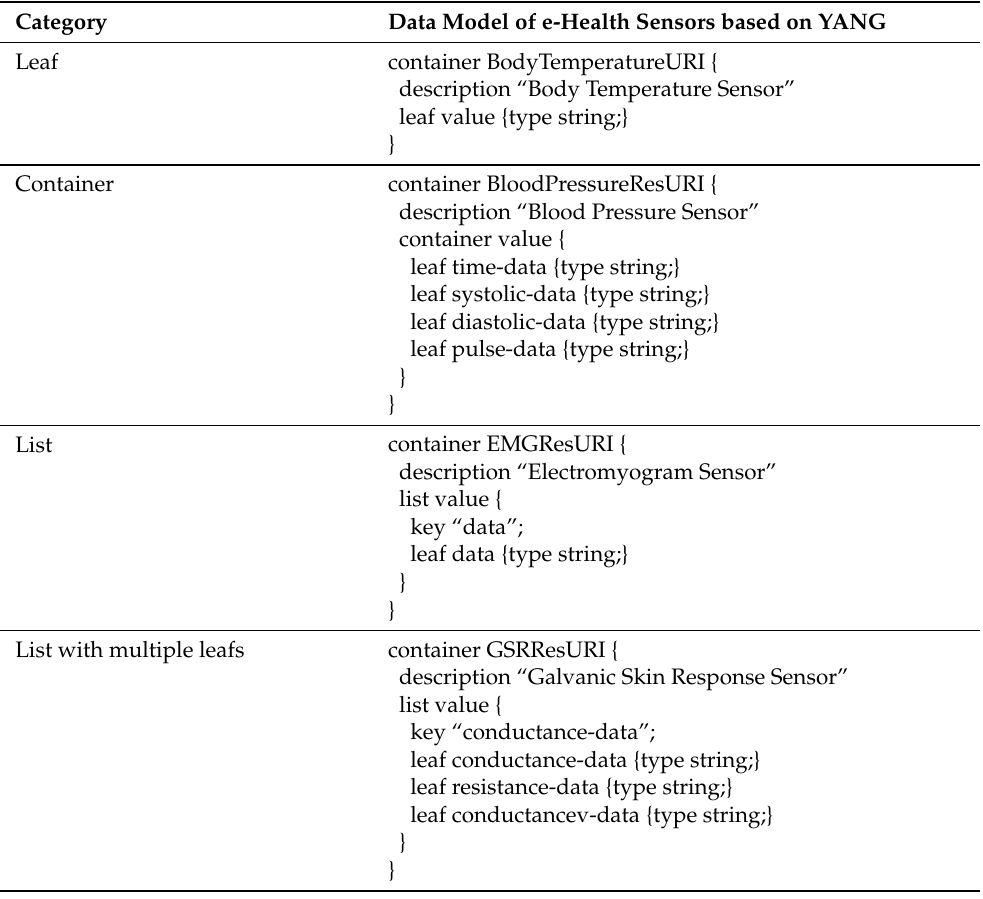
Table 2. Semantic model of e-Health sensors based on